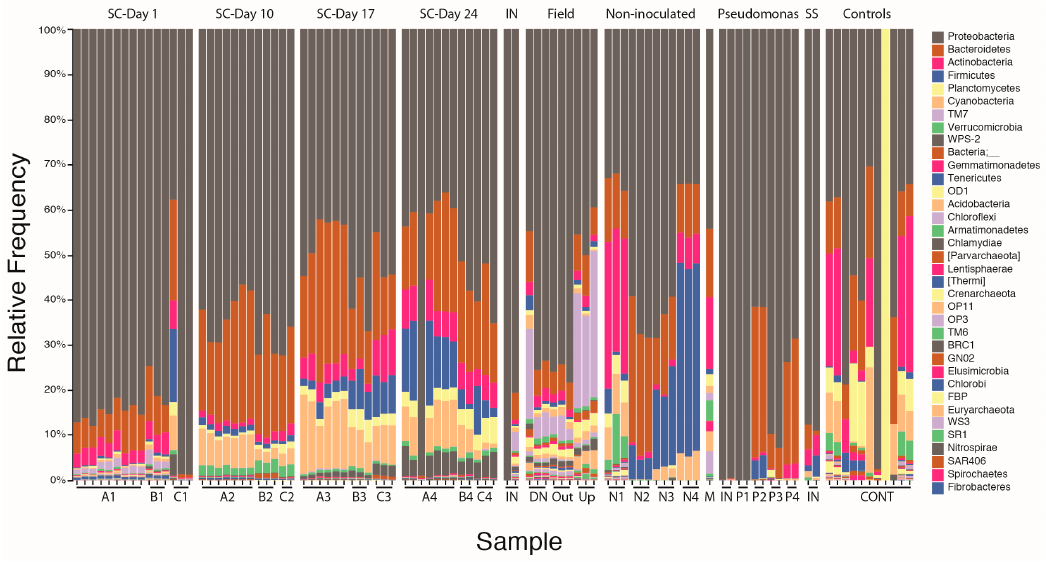
Figure 2. Taxa plots (phylum level) of microbial communities across replicate stormwater columns, Pseudomonas columns, non-inoculated columns, field samples, and controls. Legend provides phylum level classification although phyla comprising less than 1% of the samples overall are not listed. Sample type is listed about each group of samples (SC, Stormwater inoculated columns by day; IN, Stormwater column inoculum; Field, Field samples; Non-inoculated, Non-inoculated columns; Pseudomonas, Pseudomonas columns; SS, Synthetic Stormwater media; Controls, PCR control samples). Sample names ( X -axis) include column replicate (A, B, C) and time-point (1–4) for stormwater columns, inoculum type (N, non-inoculated; P, Pseudomonas ) and time-point (1–4) for non-inoculated and Pseudomonas columns, and short descriptors for other samples (DN, Downstream of outfall; Out, Outfall; Up, Upstream of outfall; M, Mix9 positive control; CONT, negative controls; IN, inoculum). Technical replicates for the same column are displayed individually.